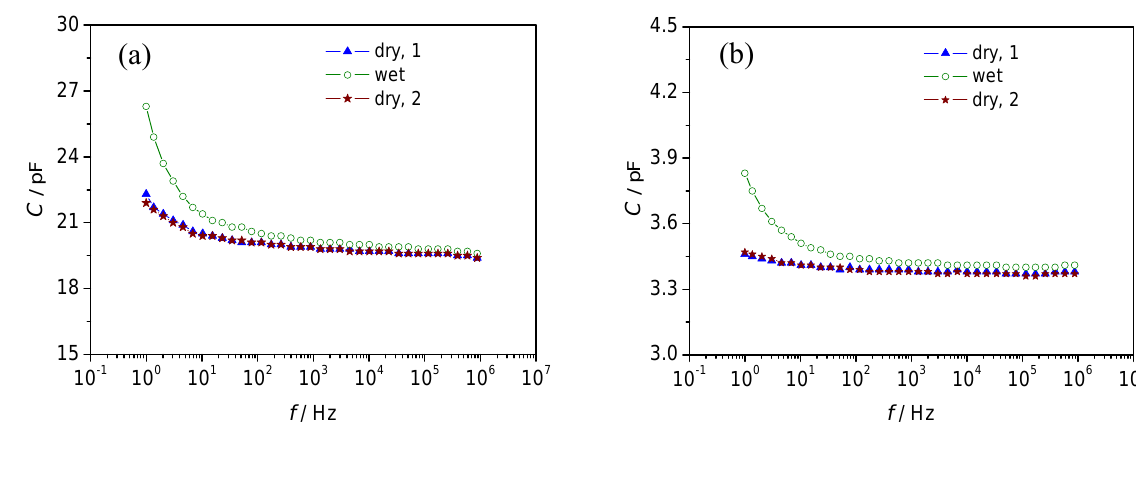
Figure 5. Sensor signal (changing capacitance C ) of Fe-BTC sensors at 120 °C in dry and O saturated N gas atmosphere (saturated at 20 °C, ~ 2.3 %vol.). (a) IDE sensor set-up, H 2 2 (b) pellets sensor. Measurement range 1 Hz - 1 MHz at 120